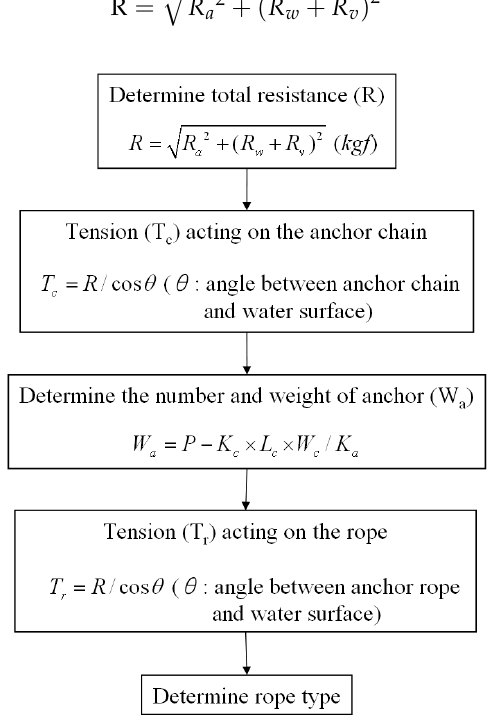
Figure 10. Flowchart for mooring system design [2].